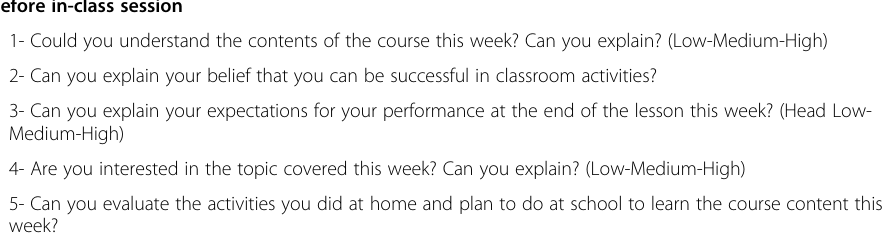
Table 5 FCM_SRL Diary Module Questions